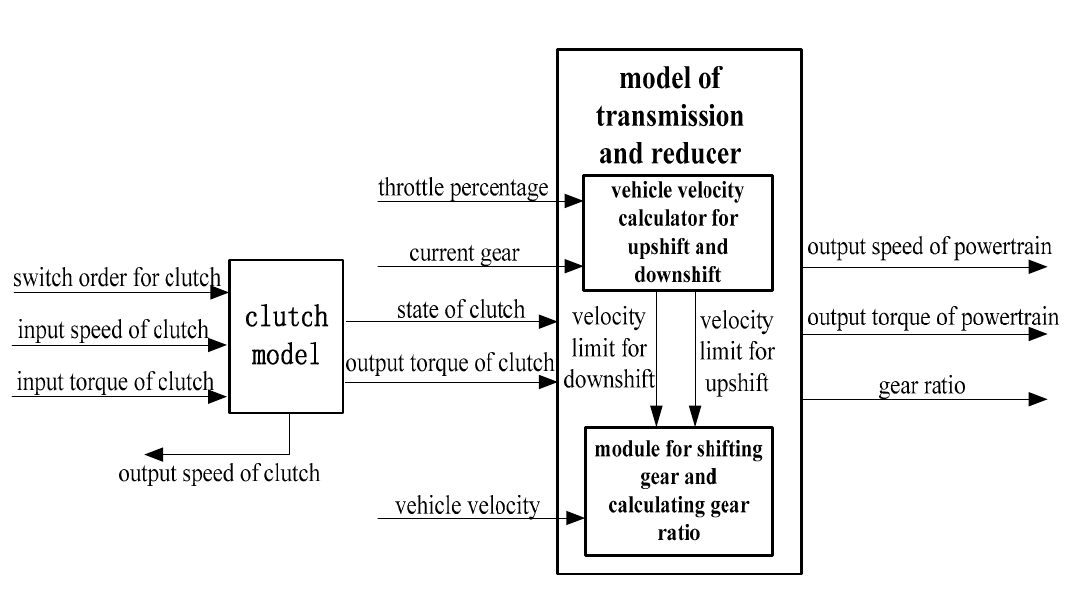
Figure 5. The powertrain model diagram.